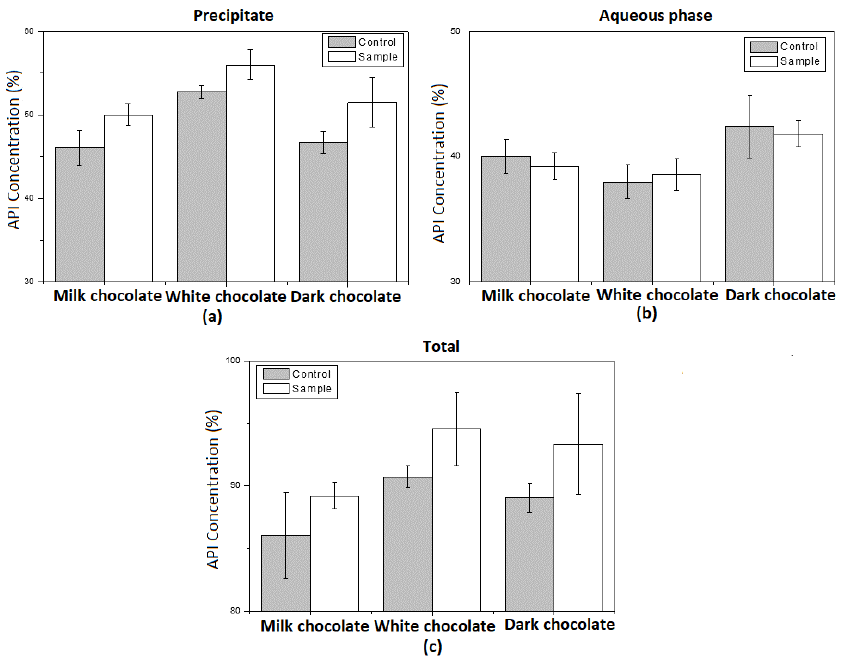
Figure 8. In vitro digestion: Amount of DSP recovered from ( a ) the aqueous phase, ( b ) the water insoluble phase and ( c ) the total of the two.